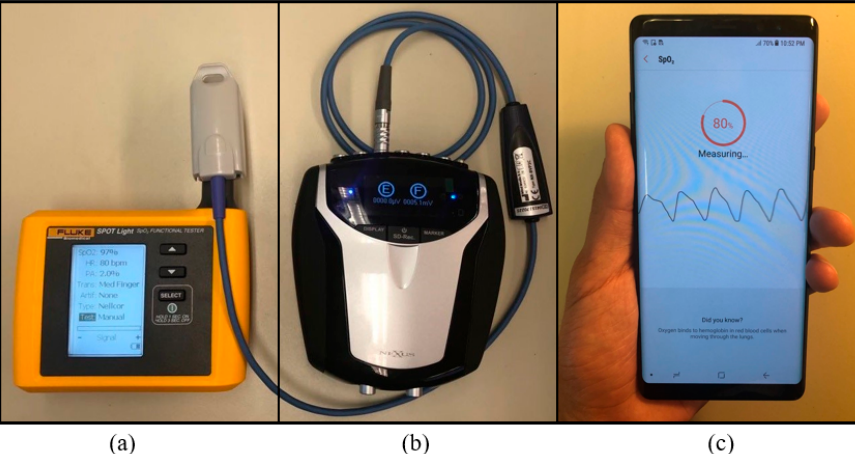
Figure 1. Our measurement and calibration devices used for data acquisition: ( a ) FLUKE device which is an emulation device to calibrate other measurement devices, ( b ) NeXus-10 MKII is FDA approved physiological signal measurement device which we use as our gold standard device in this paper, and ( c ) Samsung Galaxy Note8, a water-resistant device which is capable of measuring PPG in both dry and underwater environments.